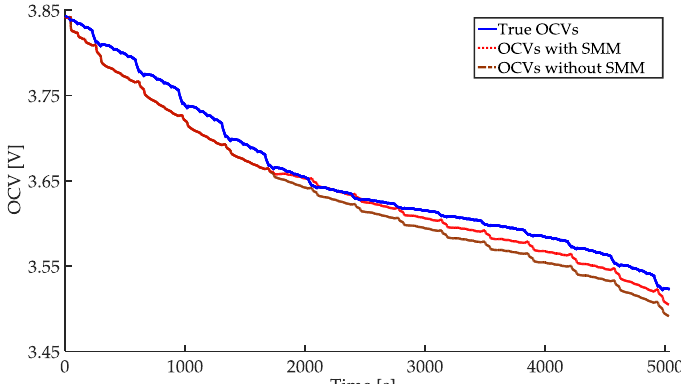
Figure 3. Comparison of true OCVs, estimated OCVs with SMM and estimated OCVs without SMM (experiment: cell A, DST 5 A and ISCr 20 Ω).